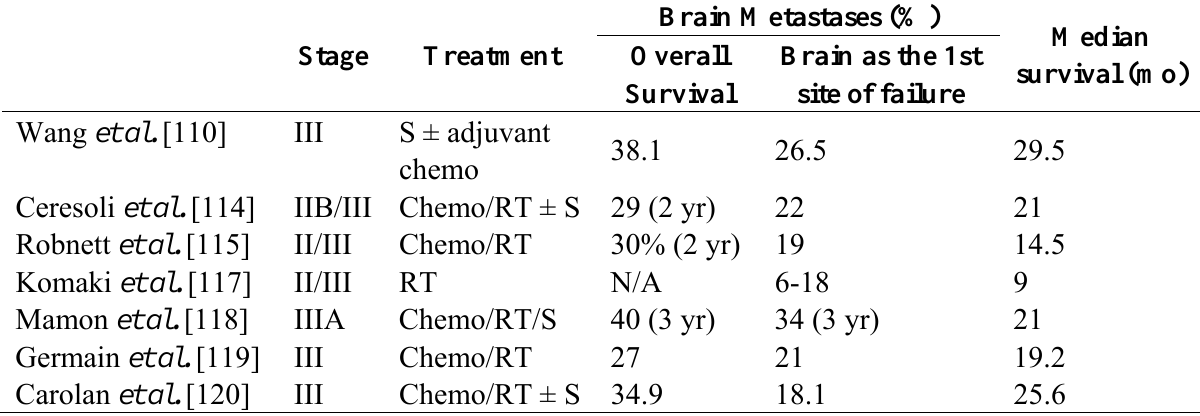
Table 7. Incidence of brain metastases after combined modality treatments for non-small cell lung cancer (NSCLC).